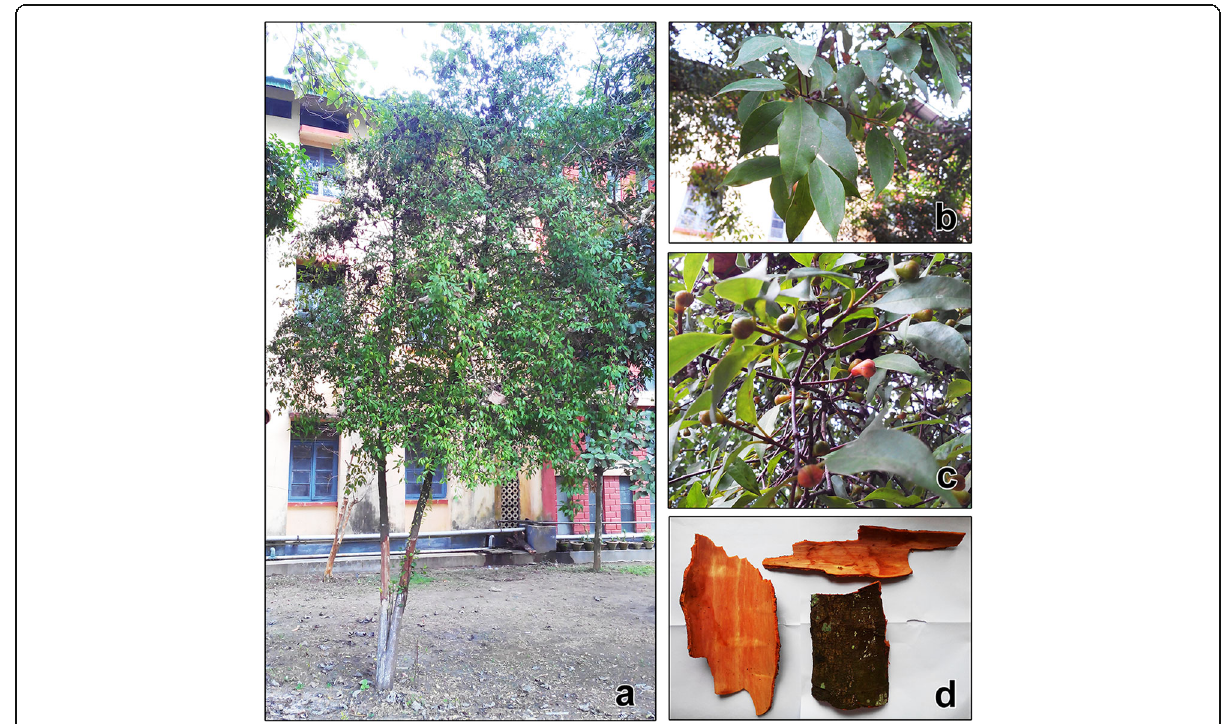
Fig. 1 Images of Garcinia lanceifolia plant. a Whole plant. b Leaves arrangement. c Young fruits. d Collected